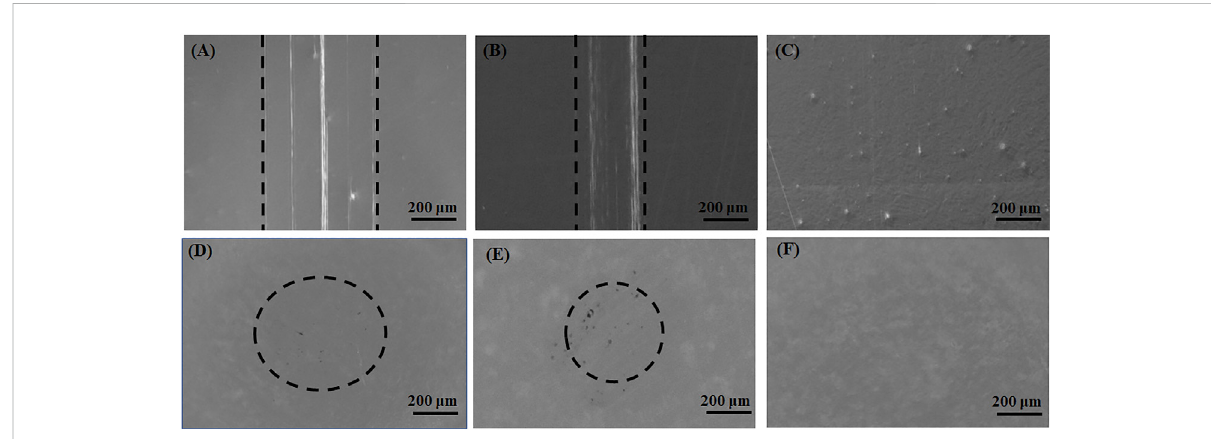
FIGURE 7 Optical microscopy images of the surfaces of stainless steel disks after tribological testing: (A) 30 wt% PEG, (B) 1.5 wt% CS, (C) PEG/CS (30 wt %/1.5 wt%). Optical microscopy images of the surfaces of ultra-high-molecular-weight polyethylene balls after tribological testing: (D) 30 wt% PEG,